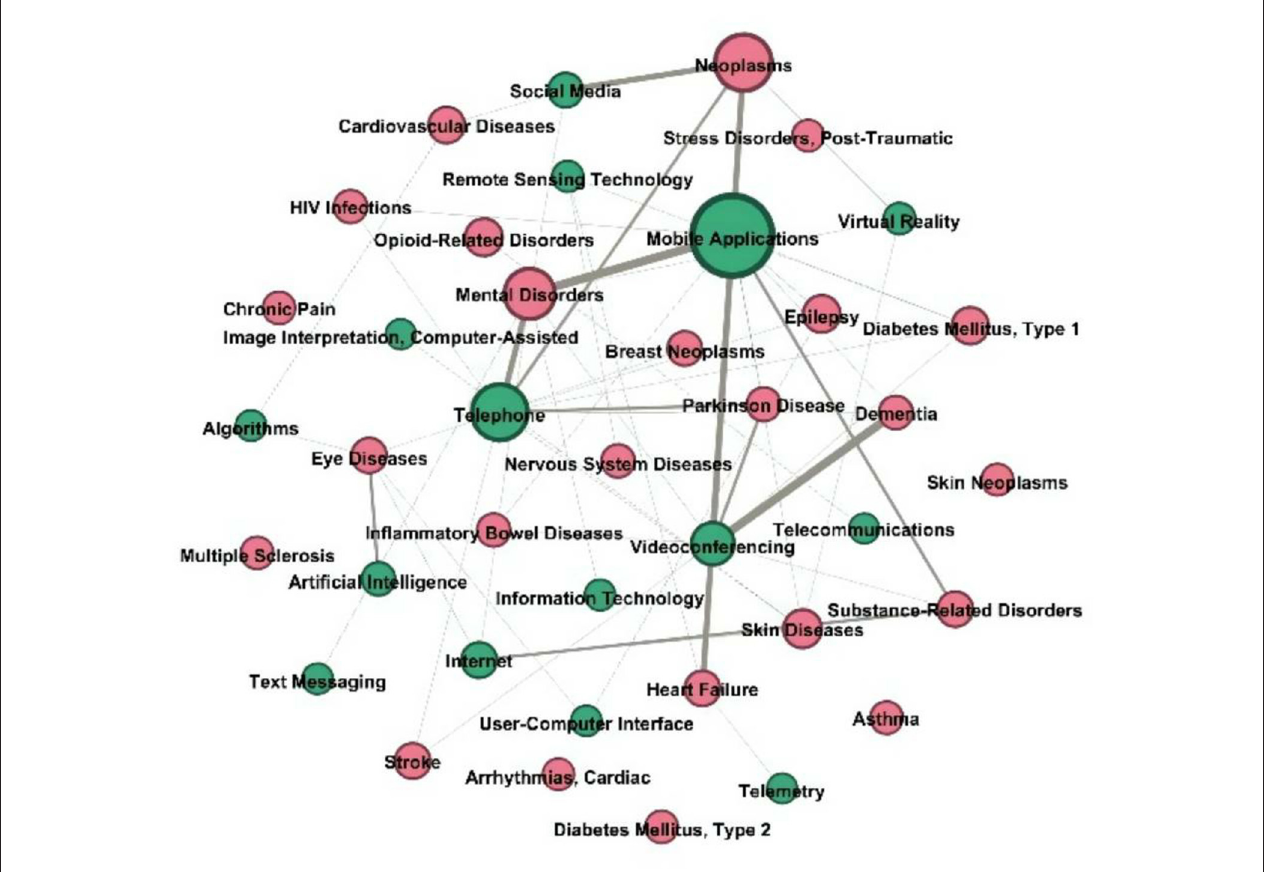
FIGURE 5 | Common diseases with IT entities